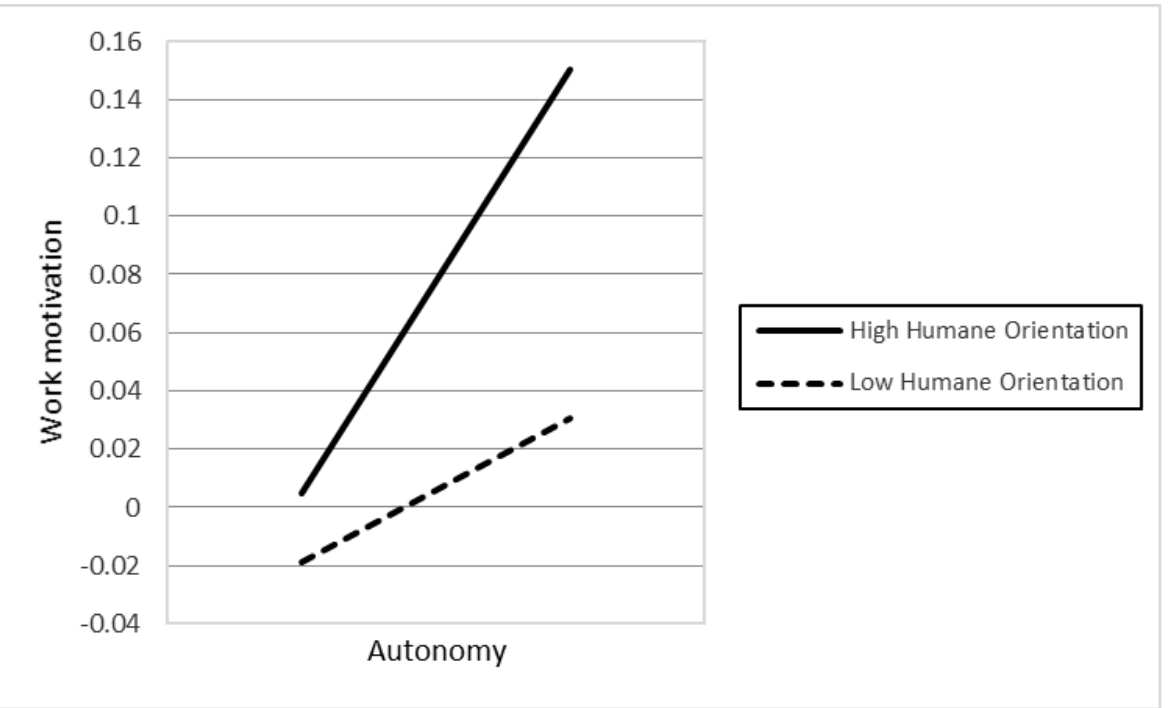
Figure 4. The association between autonomy and work motivation at different levels of humane orientation.